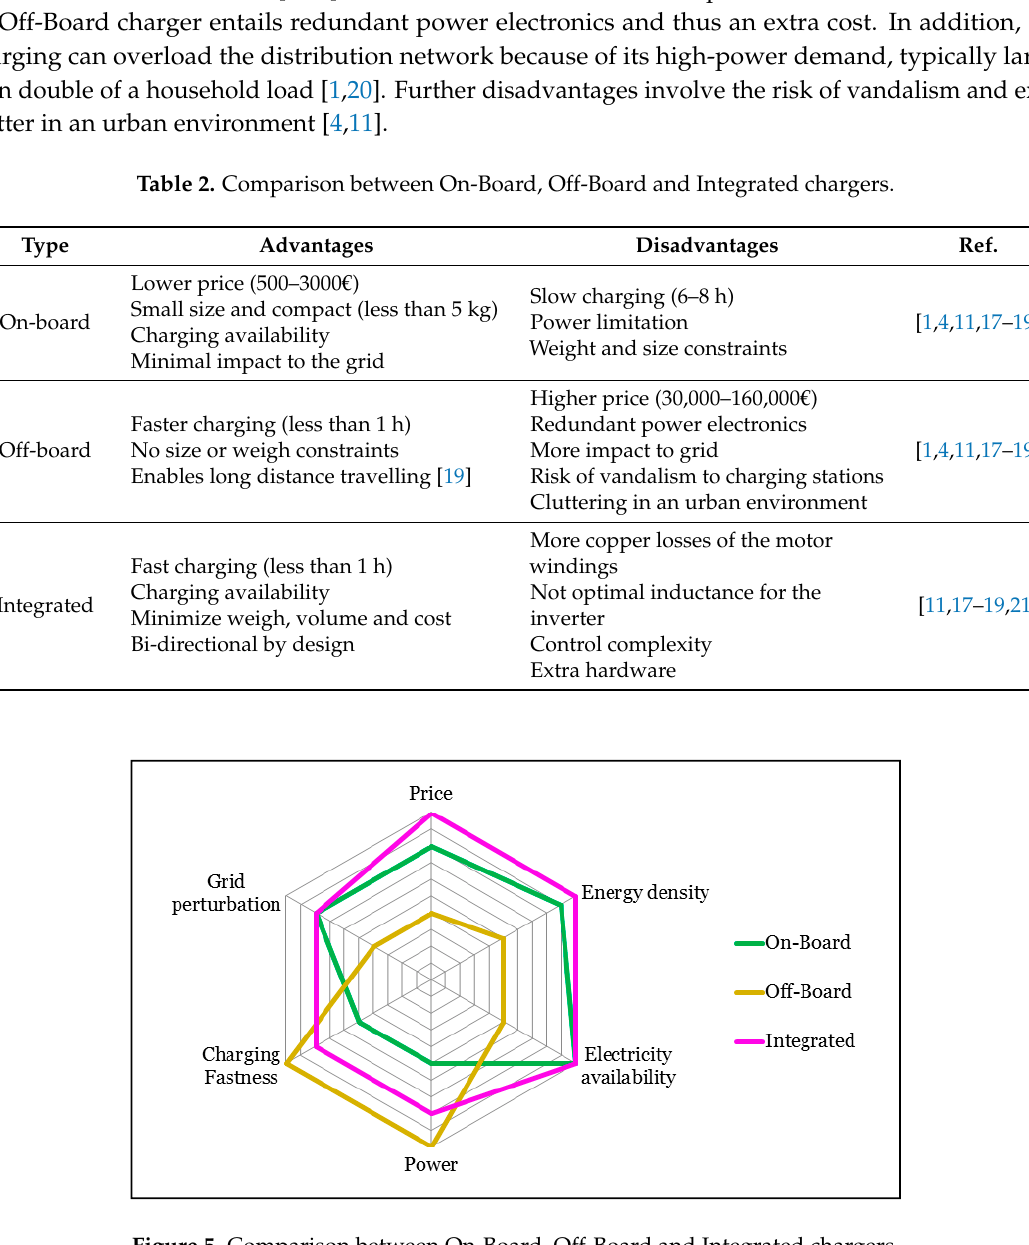
Figure 5. Comparison between On-Board, Off-Board and Integrated chargers.